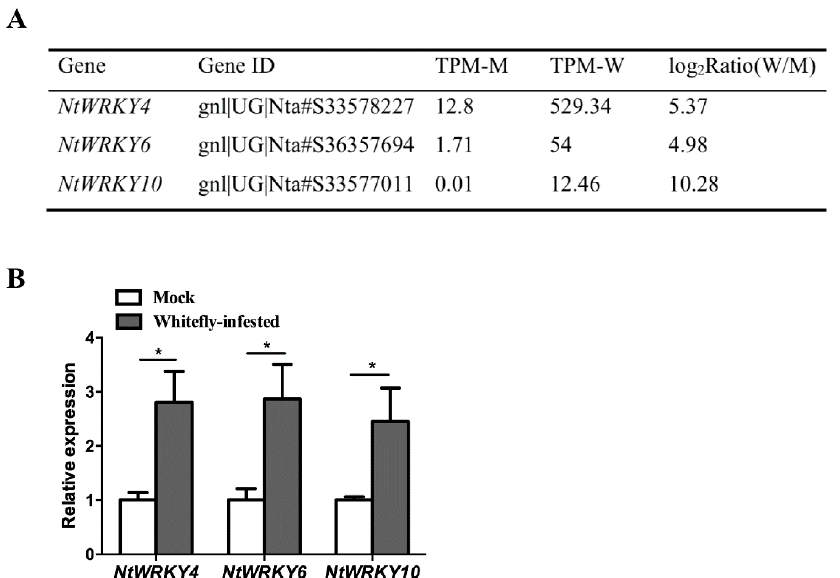
Figure 1. Whitefly infestation upregulated the expression levels of NtWRKYs . ( A ) Effect of whitefly feeding on expression of NtWRKY4 , NtWRKY6 , and NtWRKY10 from DGE database. “M” denotes the tobacco plants mock-inoculated with agrobacterium, “W” denotes whitefly infestation. ( B ) qPCR validation of expression levels of NtWRKYs after whitefly infestation. The mock and whitefly-infested treatments in each of the three combinations were analyzed using Student’s t test at a significance of * p <